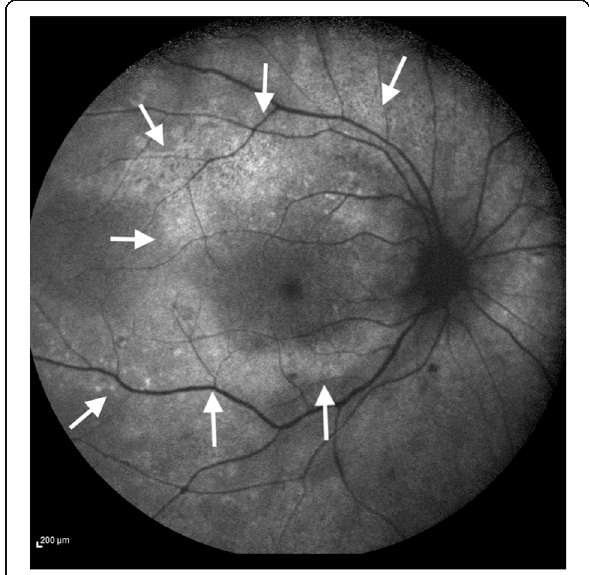
Fig. 5 Fundus autofluorescence showing a broad hyper- autofluorescence at the macular area (white